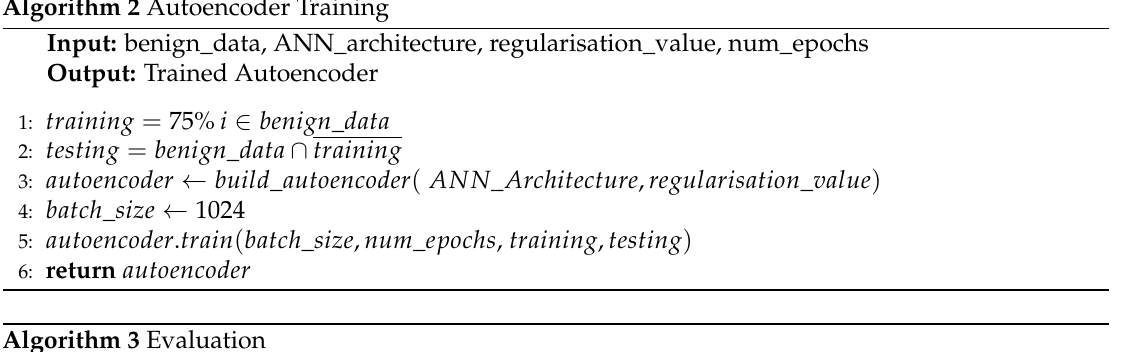
Algorithm 3 Evaluation